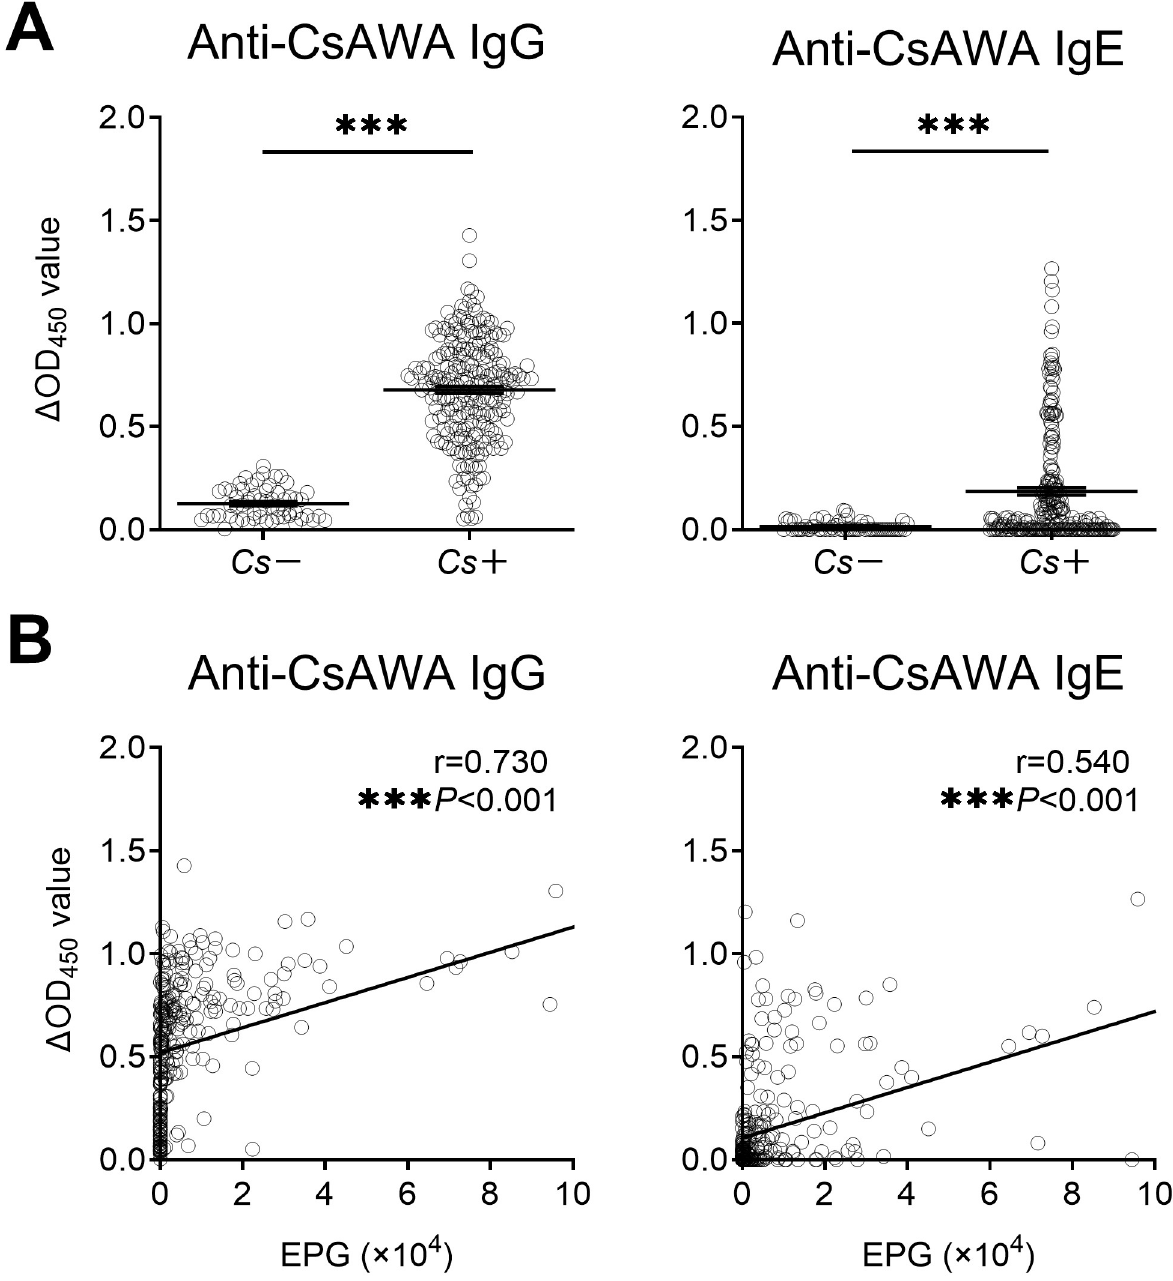
Fig 1. Serum levels of anti-CsAWA IgG and IgE in Cs - and Cs + individuals. (A) Serum levels of anti-CsAWA IgG and IgE in Cs - individuals (n = 60) and Cs + individuals (n = 229). (B) Spearman’s correlation analysis between EPG and serum levels of anti-CsAWA IgG and IgE (n = 289). CsAWA: C . sinensis adult worm antigen, Cs : C . sinensis infection, EPG: eggs per gram of feces. The data were shown as the mean ± s.e.m., ��� P < 0.001, Mann-Whitney U test in (A) , Spearman’s correlation test in (B) .